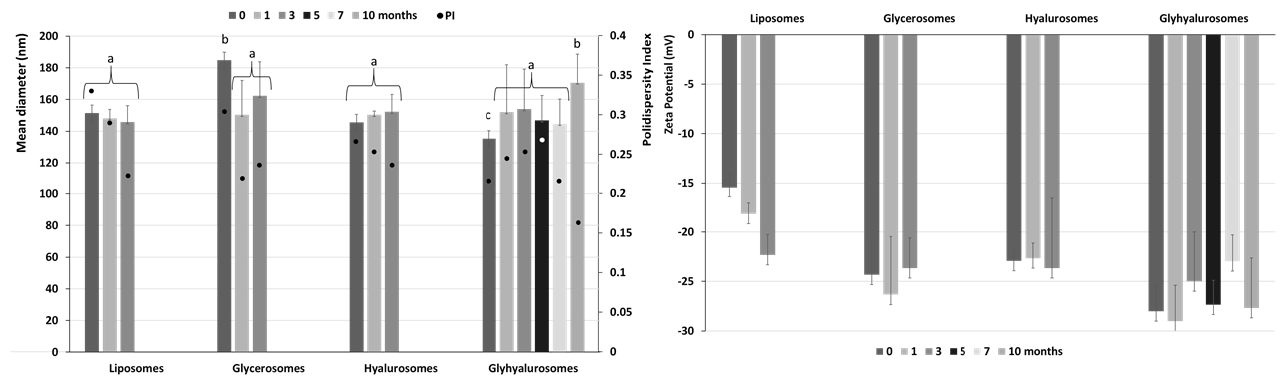
Figure 3. Mean diameter (bars), polydispersity index (dots) and zeta potential, of the extract loaded vesicles stored at 4 °C for 10 months. Data represent the means ± SD of at least six replicates. Each symbol (a, b, c) indicates the same value of mean diameter. Table 2. Droplet size analysis of Z. officinalis vesicles sprayed from a distance of 4 and 7 cm from the laser beam. Standard deviation ( ± ) is expressed as the mean of 3 measurements. Each symbol (a, b, c, d, e, f) indicates the same value.